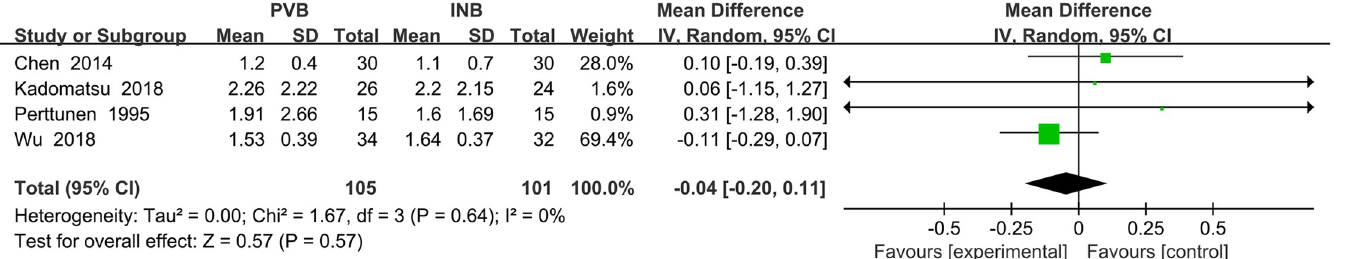
PLOS ONE | https://doi.org/10.1371/journal.pone.0237363 October 5,